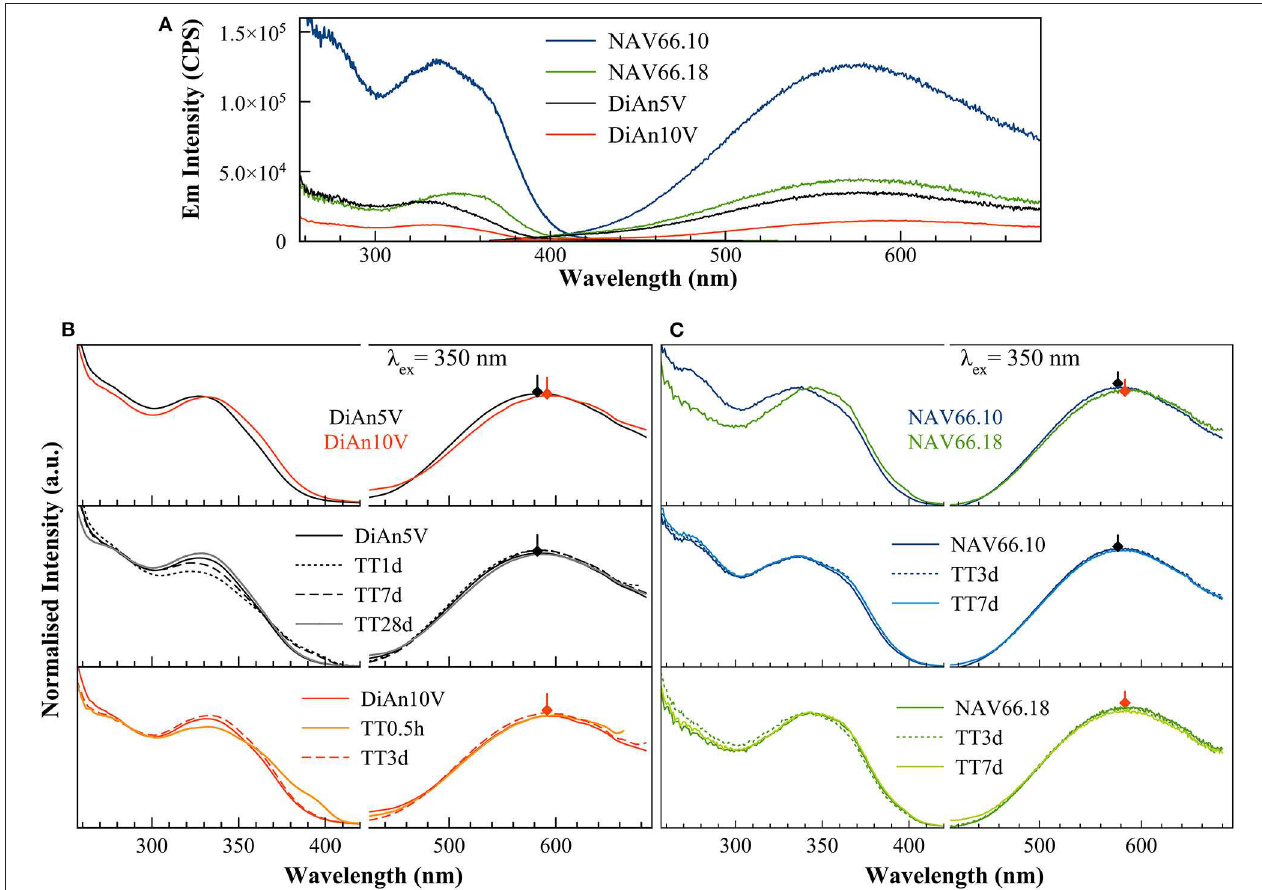
FIGURE 5 | (A) Raw excitation and emission spectra of V-doped DiAn and NAS glasses. There is an intensity drop of the photoluminescence emission depending on the bulk composition. (B) Excitation (Ex) and Emission (Em) spectra of V-doped Dian glasses normalized to their total area. The increase of V content induces a redshift of both Ex and Em. TT above 3 days as well-produced changes in the excitation lines. (C) Normalized photoluminescence spectra for NAS glasses. The increase of the Al/Na molar content induces a redshift of both Ex and Em bands.